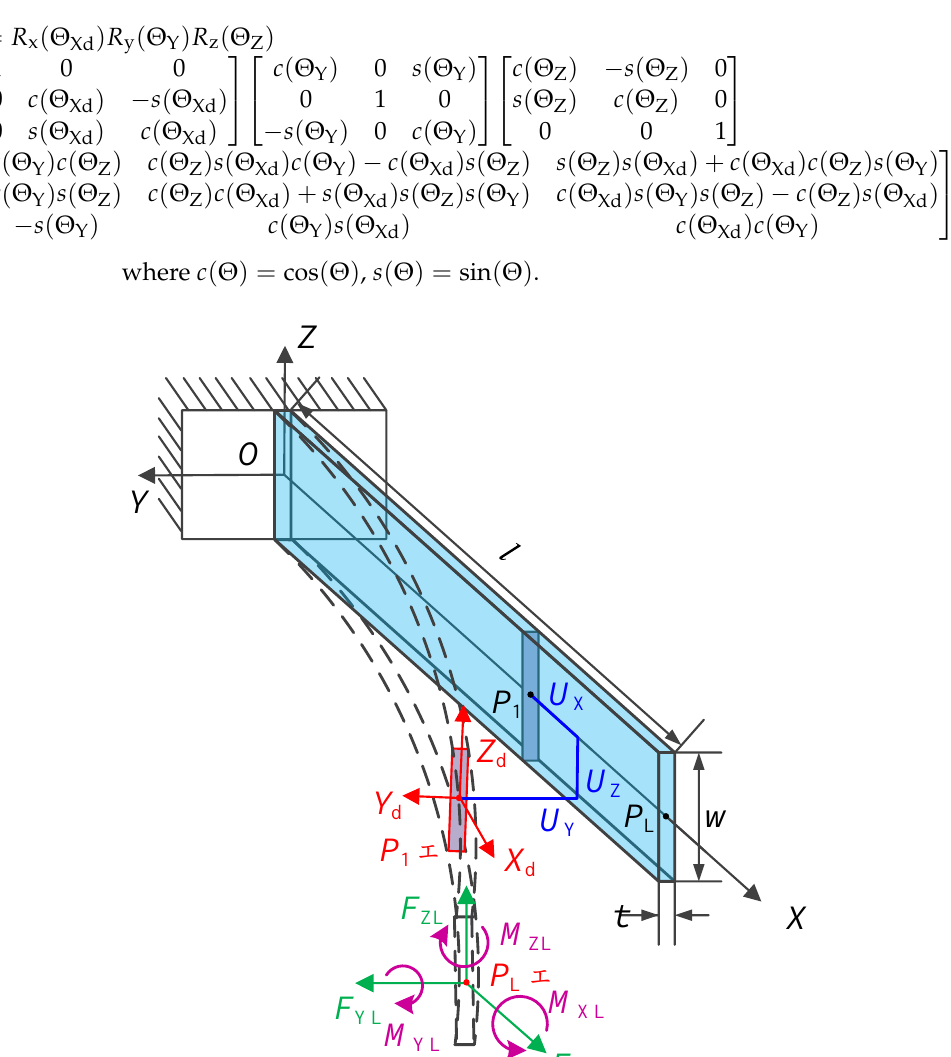
Figure 1. Six-DOF spatial deformation of the FLS.